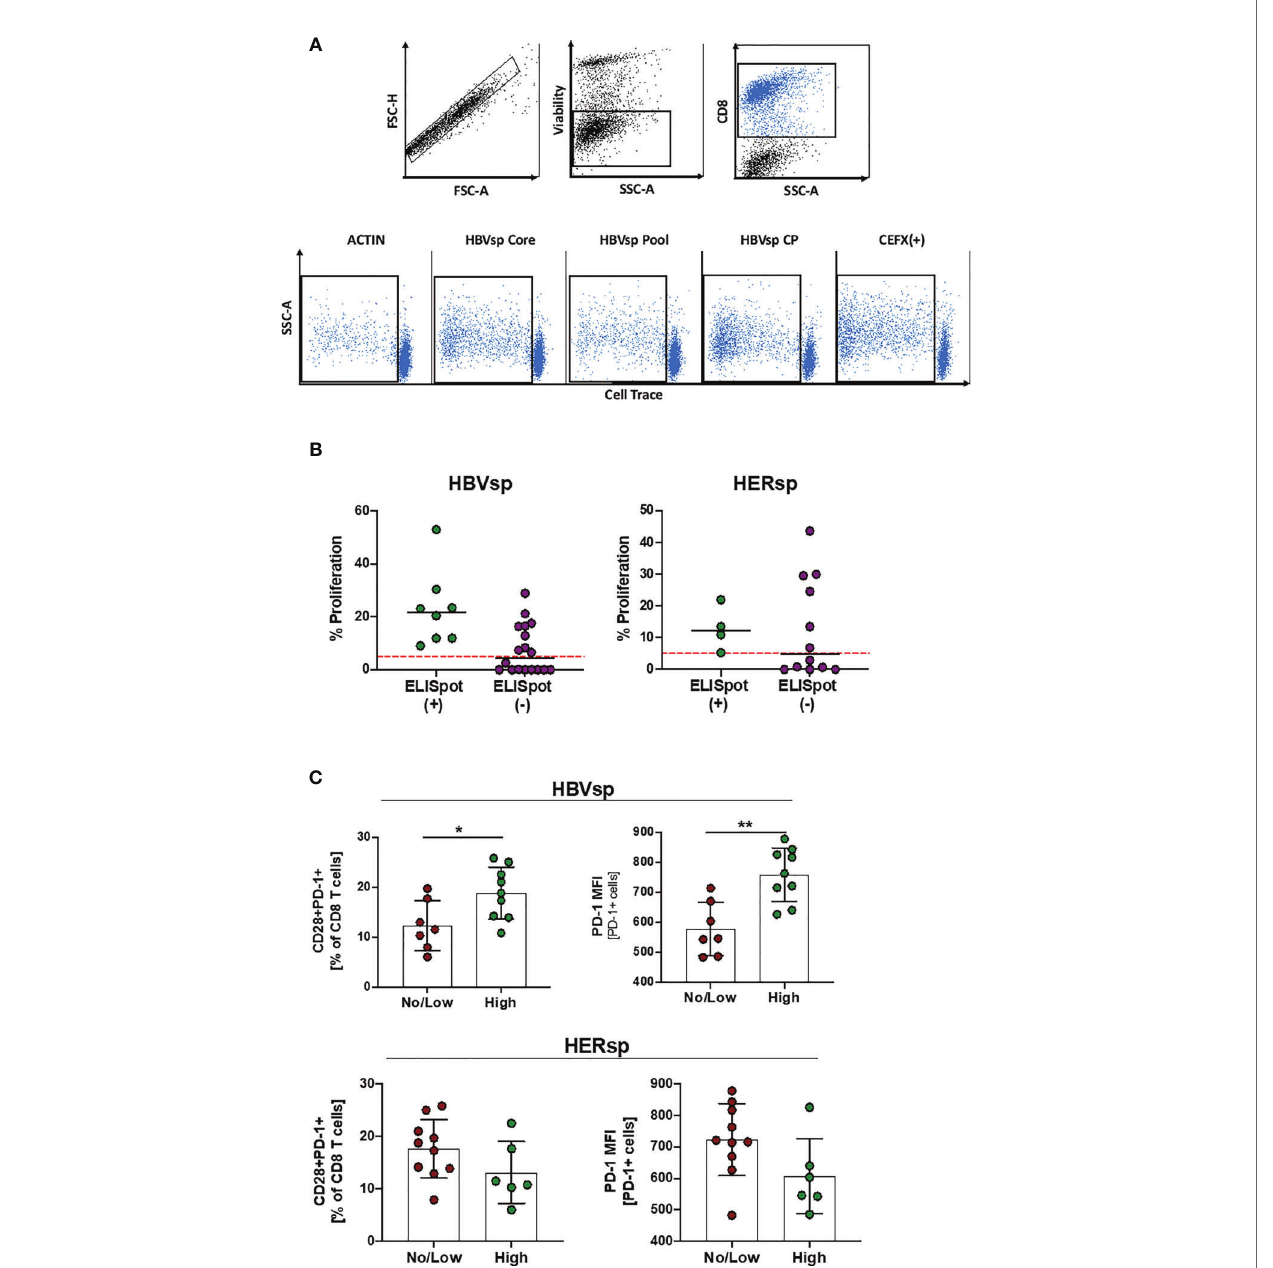
FIGURE 4 | T cell expansion unveils Ag-speci fi c T cells in ex vivo not-reactive samples. (A) Representative fl ow plots showing the gating strategy for the cell trace dilution assay. (B) Frequency of CD8 proliferating cells among reactive and non-reactive samples for both HBV-speci fi c (core and/or pool) and HERPES-speci fi c (CMV and/or EBV) assays. (C) Baseline frequency of CD28+PD-1+ CD8 T cells and the mean fl uorescence intensity (MFI) of the PD-1 marker on CD8 T cells among samples with low or high proliferation levels. *p < 0.05; **p < 0.001; Mann Whitney